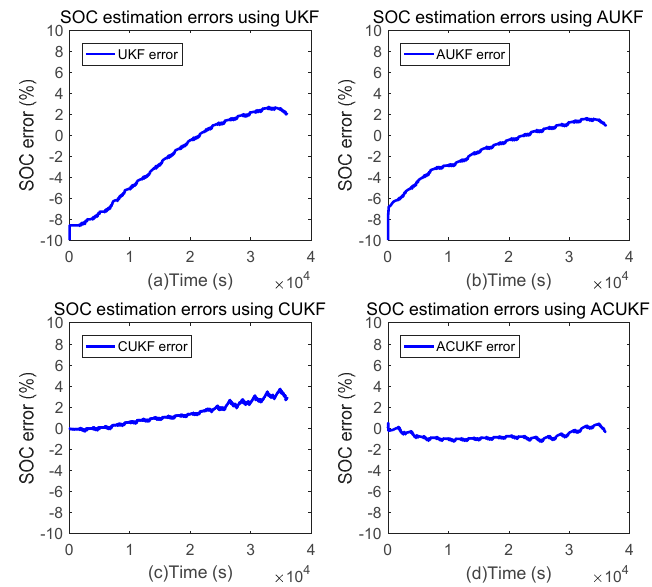
Figure 10. SOC estimate error comparison using different methods under shot noise. ( a ) SOC estimate error of UKF; ( b ) SOC estimate error of AUKF; ( c ) SOC estimate error of CUKF; ( d ) SOC estimate error of ACUKF.